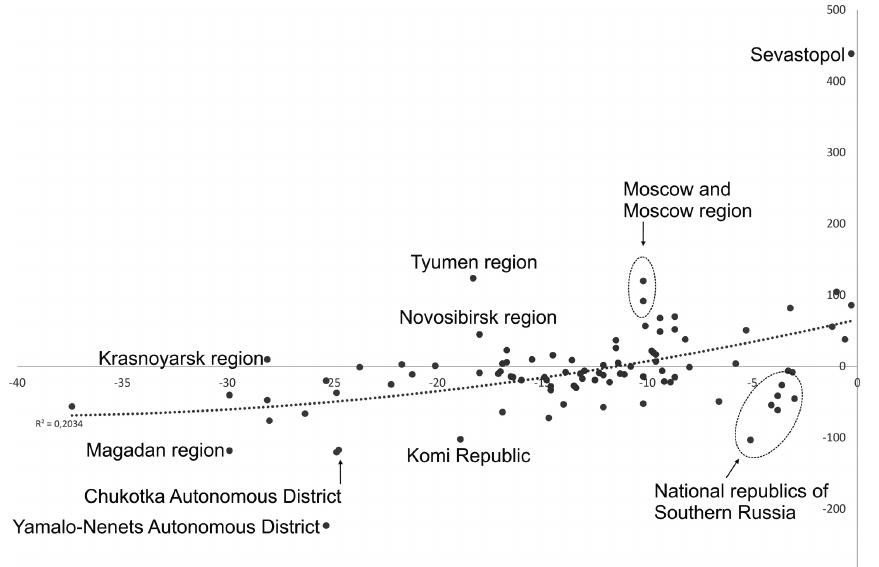
Fig. 1. Average January temperature (°C) according to climatic norm (horizontal scale) and population migration (per 10,000 people) in the regions of Russia in 2015 (vertical